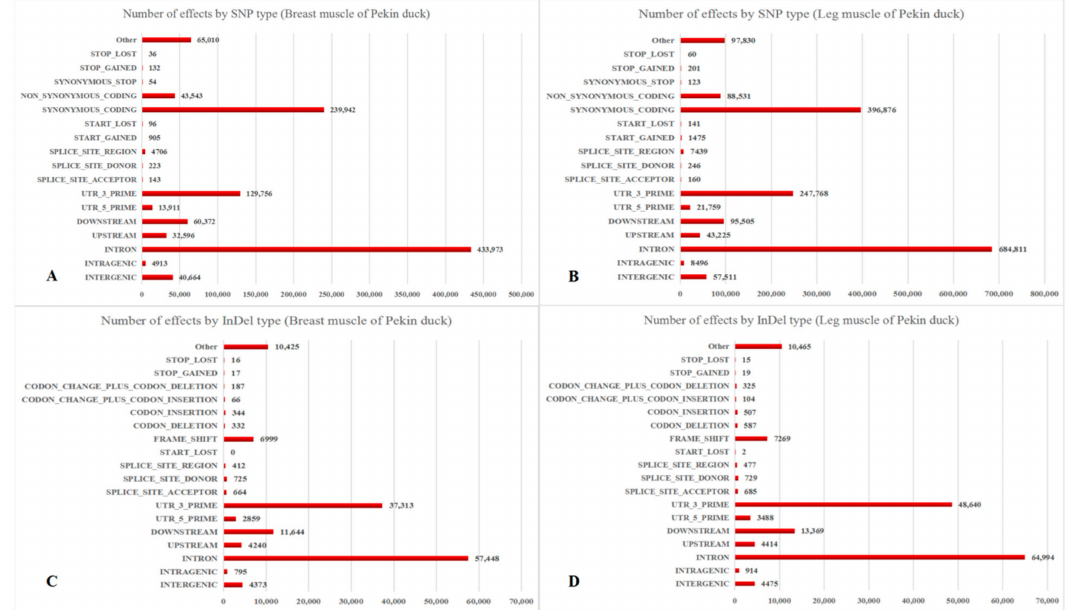
Figure 1. Annotation and classification of SNPs (single nucleotide polymorphisms) and InDels (insertion-deletions) in Pekin duck. ( A ) SNPs of breast muscle; ( B ) SNPs of leg muscle; ( C ) InDels of breast muscle; ( D ) InDels of leg